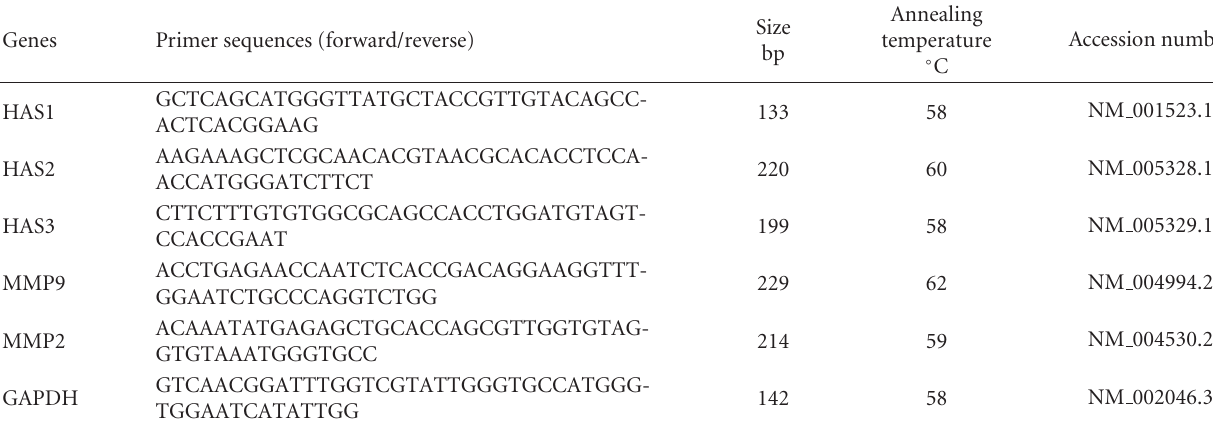
Table 1: Primer sequences for real-time